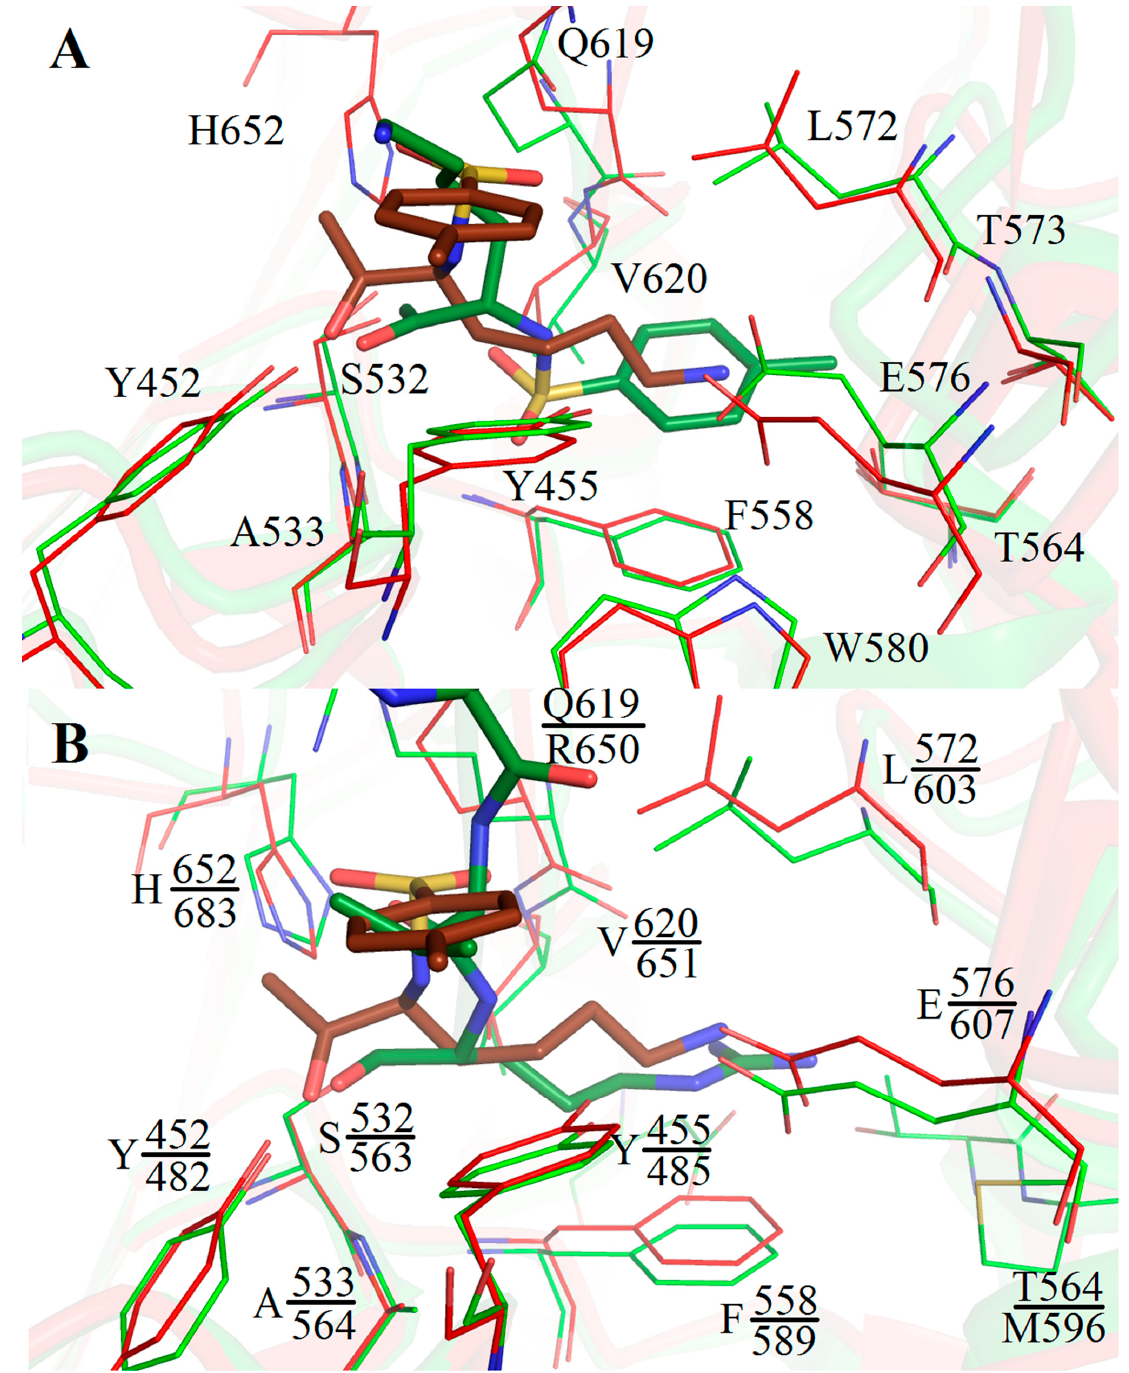
Figure 5. Amino acid surroundings of the covalently bound inhibitors in the SpOpB-TCK